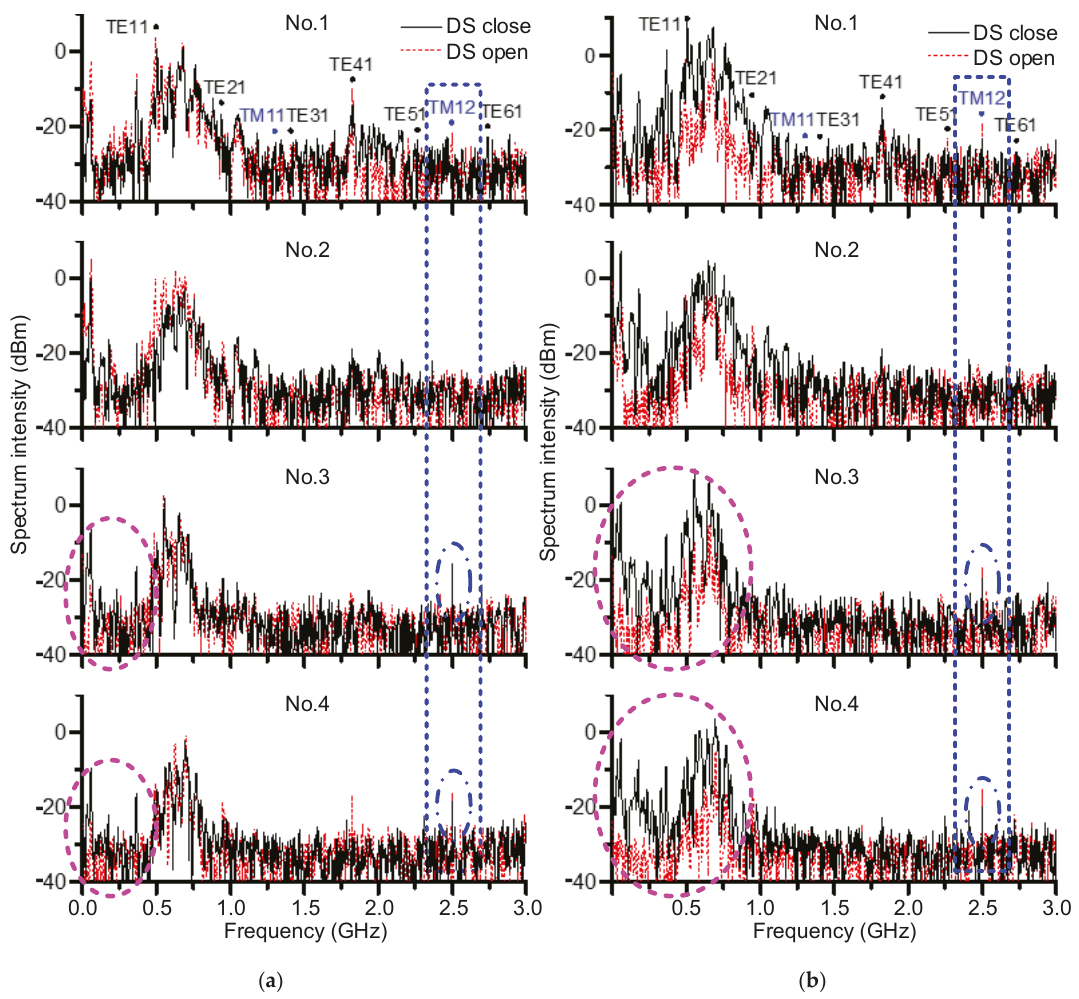
Figure 9. Comparison of EM wave spectra ( θ = 0 ◦ ). ( a ) 6.5 kV; ( b ) 9.6